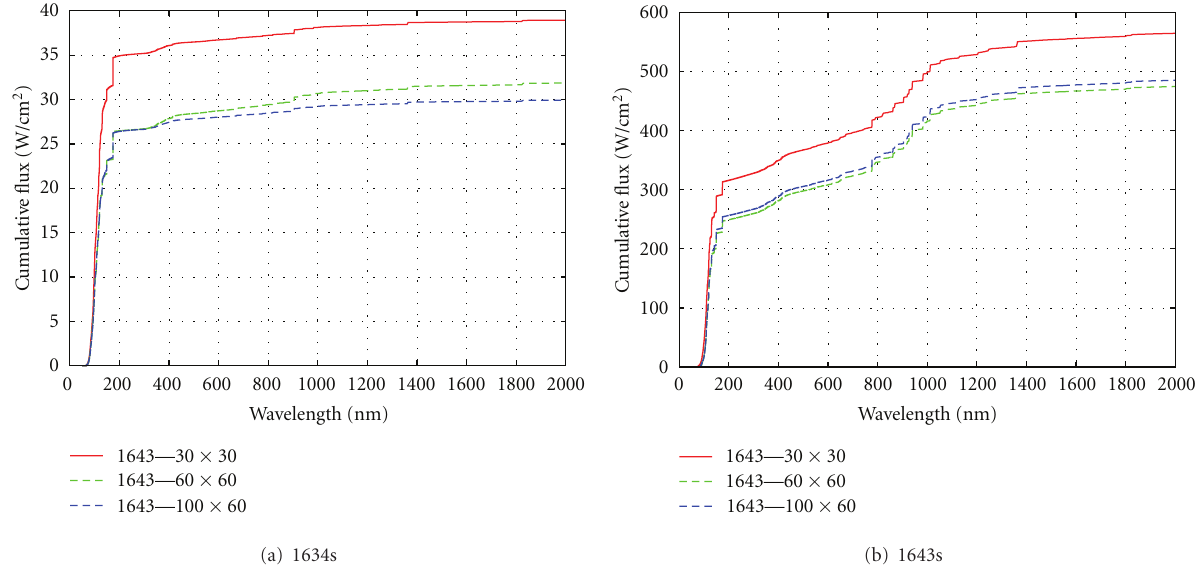
Figure 2: Grid convergence analysis.